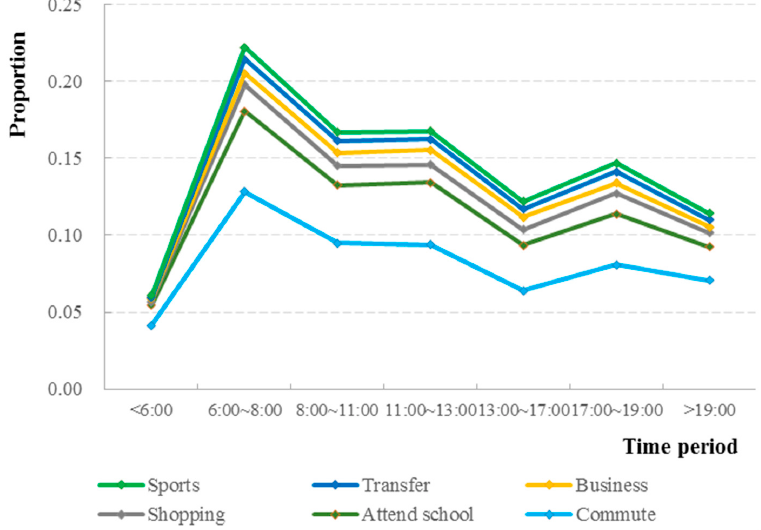
Figure 5. Time period of travel for FFBS.